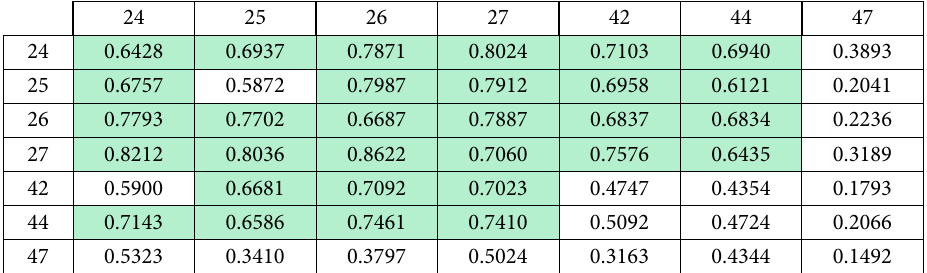
Table 17. Total influence matrix T